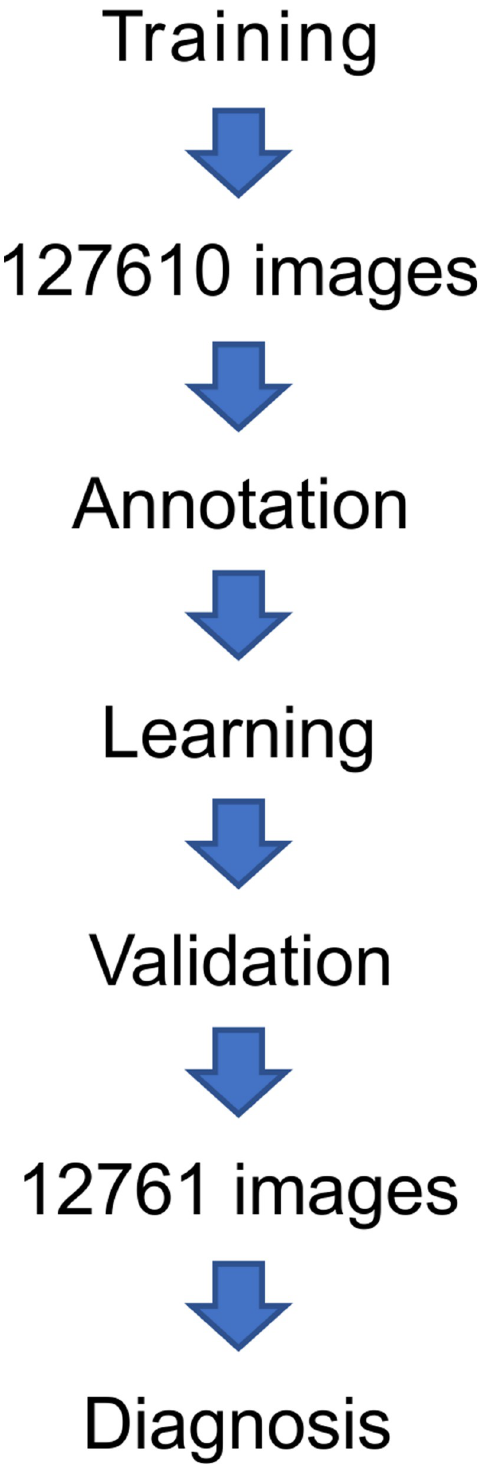
Fig 2. Flow chart of the study